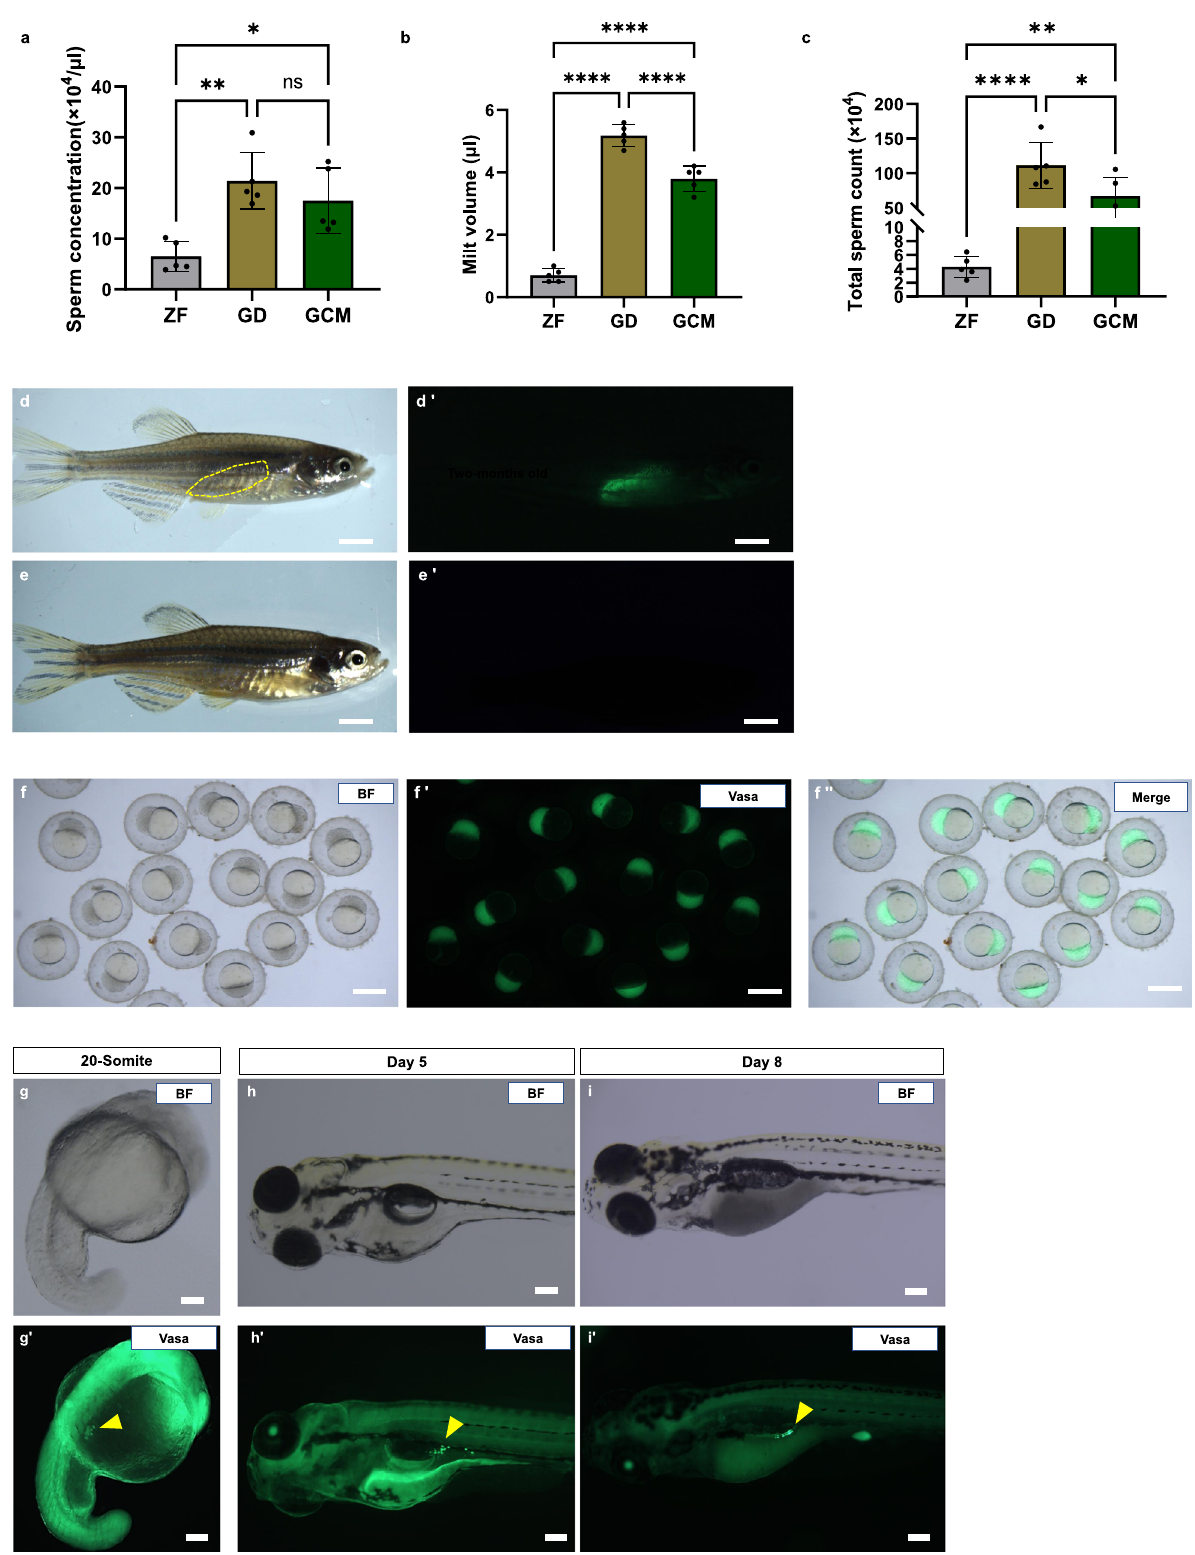
This represents the fi rst report of zebra fi sh germ cell transplant into a host of a different genus. Although there are advanced methods developed for zebra fi sh sperm cryopreservation invol- ving pooling the semen from many individuals 5 digestion of whole testes 8 , it is challenging to cryopreserve the small volume of semen produced by an individual male 8 . Milt volume